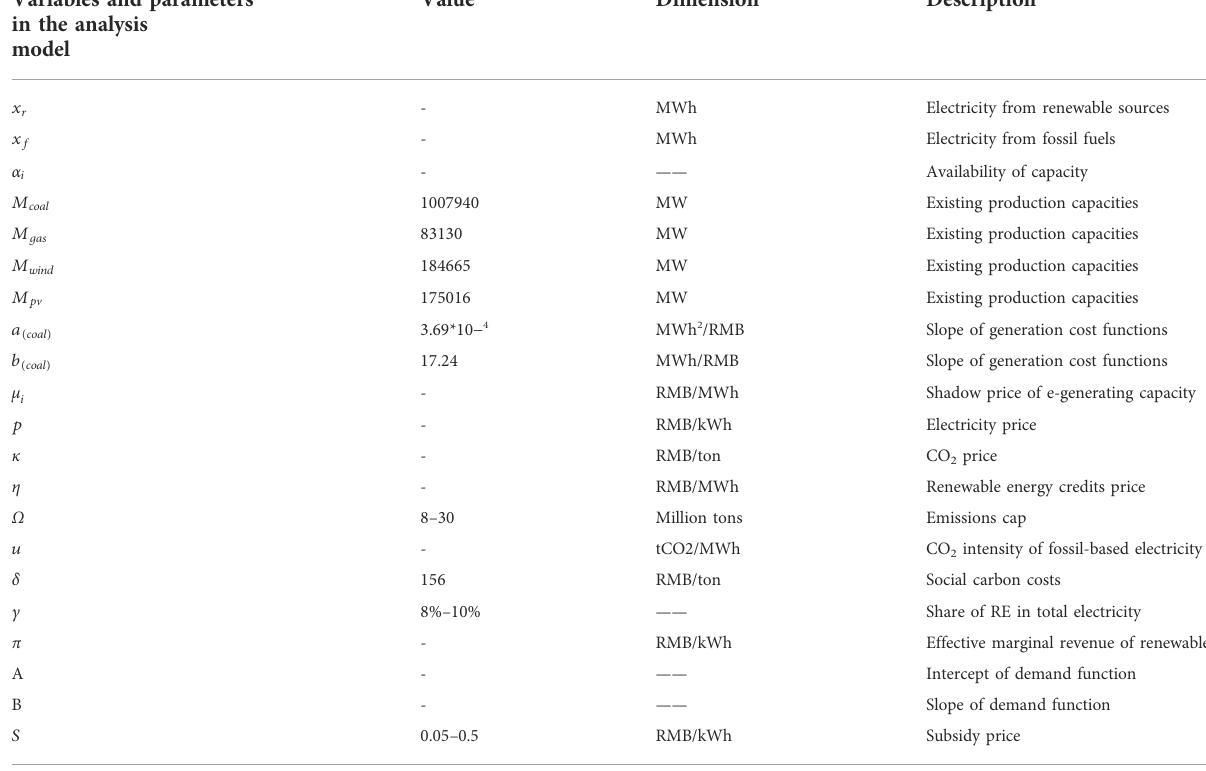
TABLE 1 Variables and parameters in the analysis model.